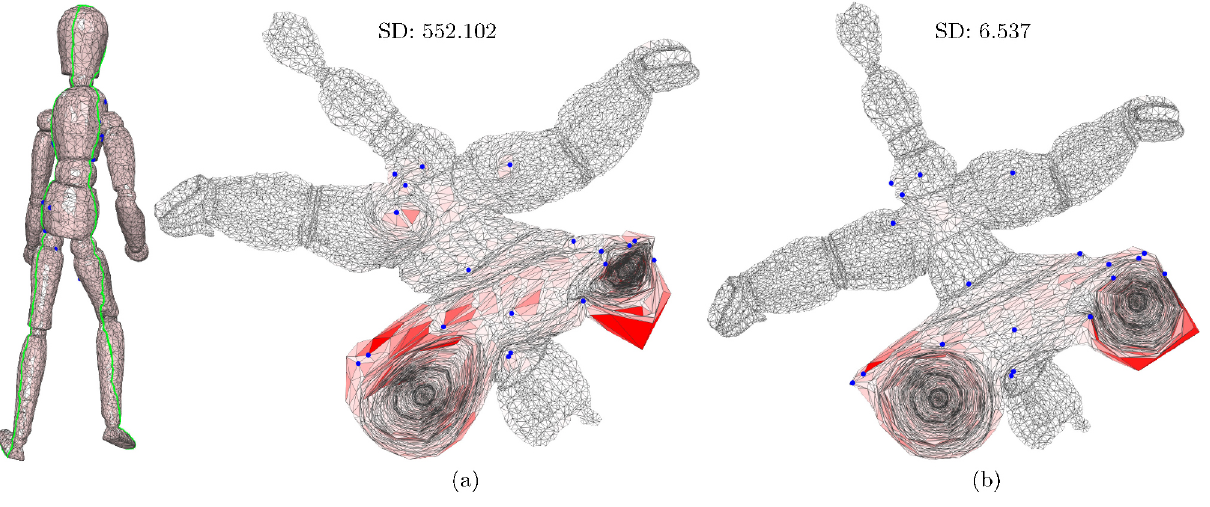
Fig. 8 Distortion optimization step. The results without (a) and with (b) the distortion optimization step, for the same positional constraints. SD is the symmetric Dirichlet distortion